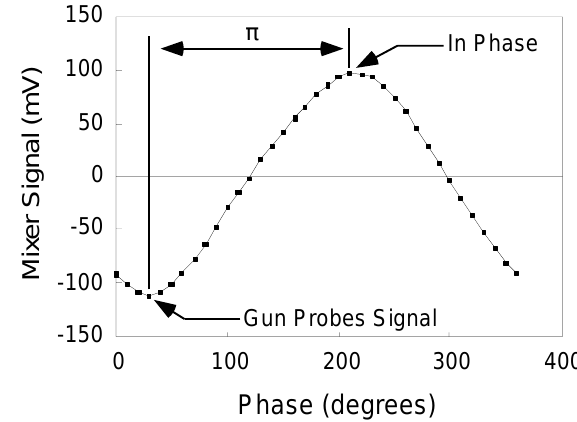
FIG. 5. The calibration curve of the interferometer, showing the mixer signal as a function of phase shifter phase setting. Setting the phase shifter to give a maximal result during calibra- tion yields a minimal result when measuring the gun, indicating a p -phase shift between the two cells.